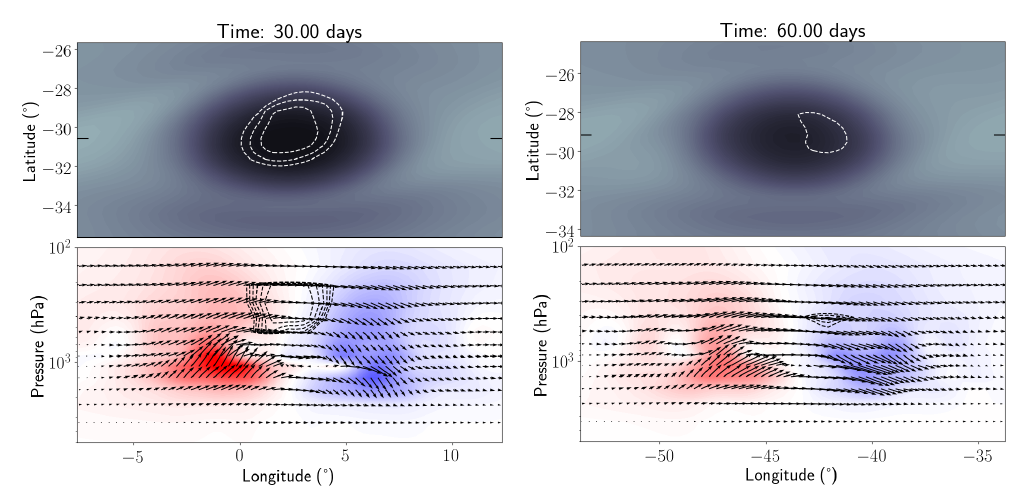
Figure 8. Wind field in a vertical plane of constant latitude defined by the center of the vortex. The vertical velocity component is multiplied by a factor of 150 to make visible, with actual maximum vertical velocities corresponding to 20 cm/s. Colors correspond to vertical velocity with red upward and blue downward. The vertical extent of the ice cloud is indicated by the dashed contours.